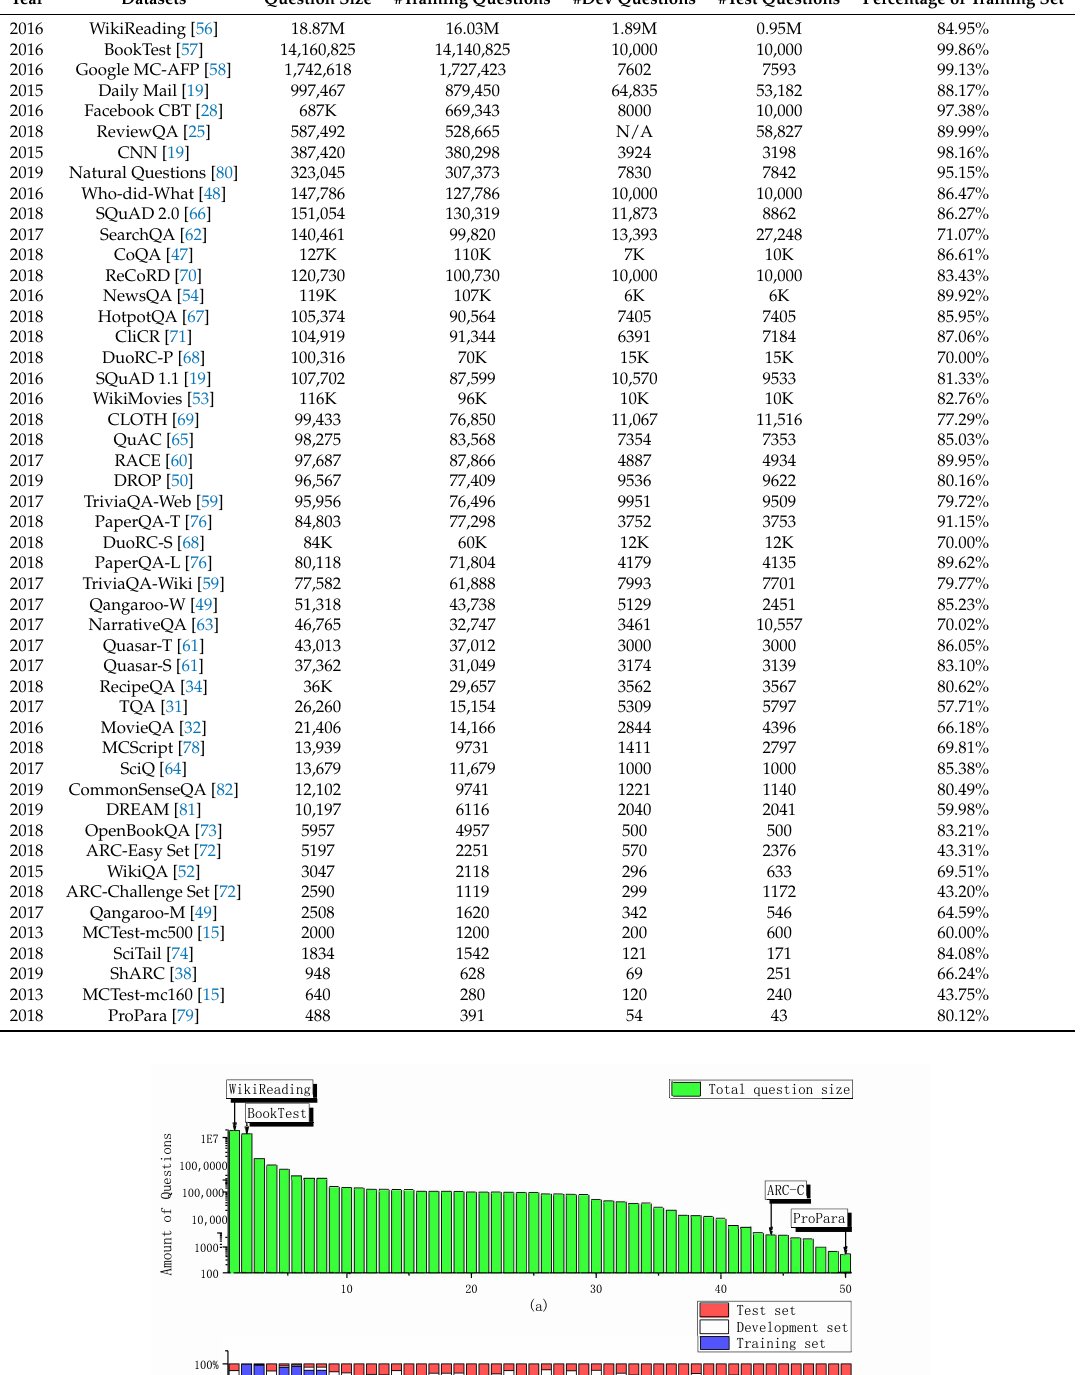
Table 4. The question set size of machine reading comprehension datasets.